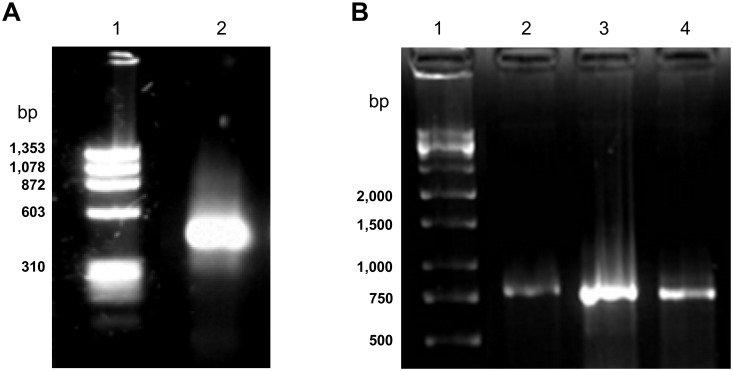
Agarose gel electrophoresis of Mo-CBP3 cDNA fragments amplified by PCR.A. 3′ RACE products (lane 1). B. 5′ RACE products amplified using 3 distinct gene-specific primers (lanes 1, 2 and 3). Lane M (A and B): molecular markers.